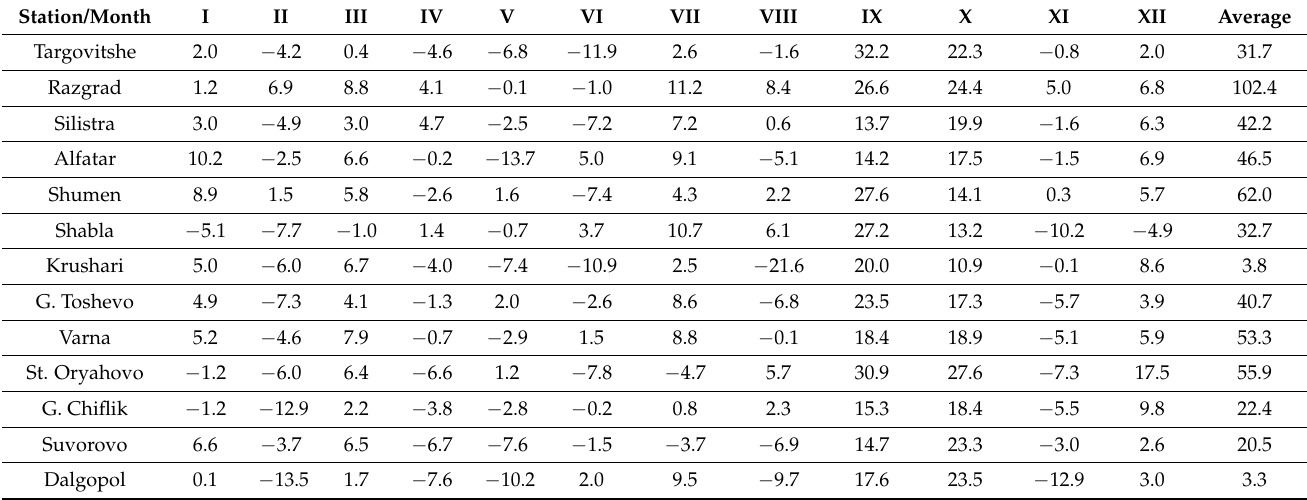
Table 8. Average monthly sums of rainfall deviations in northeastern Bulgaria in the period 1986–2015.